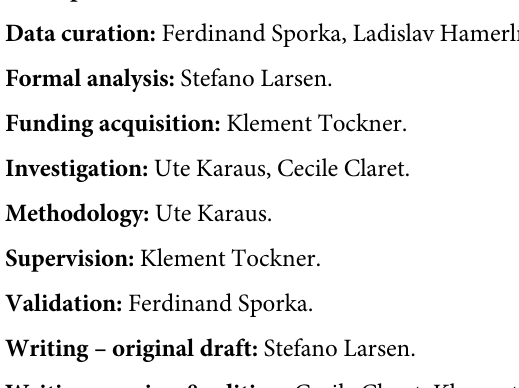
represent one month. Decreasing variation (especially along the first axis) with increasing con- nectivity is evident. S3 Fig. Composition changes after floods. Relationship between hydrologic connectivity and changes in taxonomic composition as expressed by the first Correpondence Analysis (CA) axis scores. Each panel shows changes in CA axis 1 scores between consecutive months during which flooding occurred. No significant correlations were observed, but for clarity a dashed line was included to show the direction of change. S4 Fig. Temporal changes in abiotic distance between sites. Temporal changes in mean (SE) Euclidean distance among floodplain waterbodies based on the main physico-chemical param- eters. Blue vertical lines represent flooding events. There is no consistent indication of a decline in distance (i.e. abiotic homogenisation) with the occurrence of floods. Data from the first and last months (month 4 and 3, respectively) were not